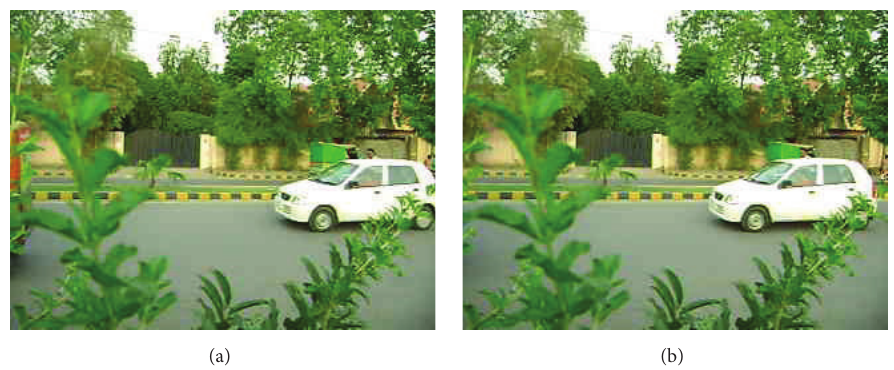
Figure 9: Sample frames from a video captured using a handheld camera with a moving car.